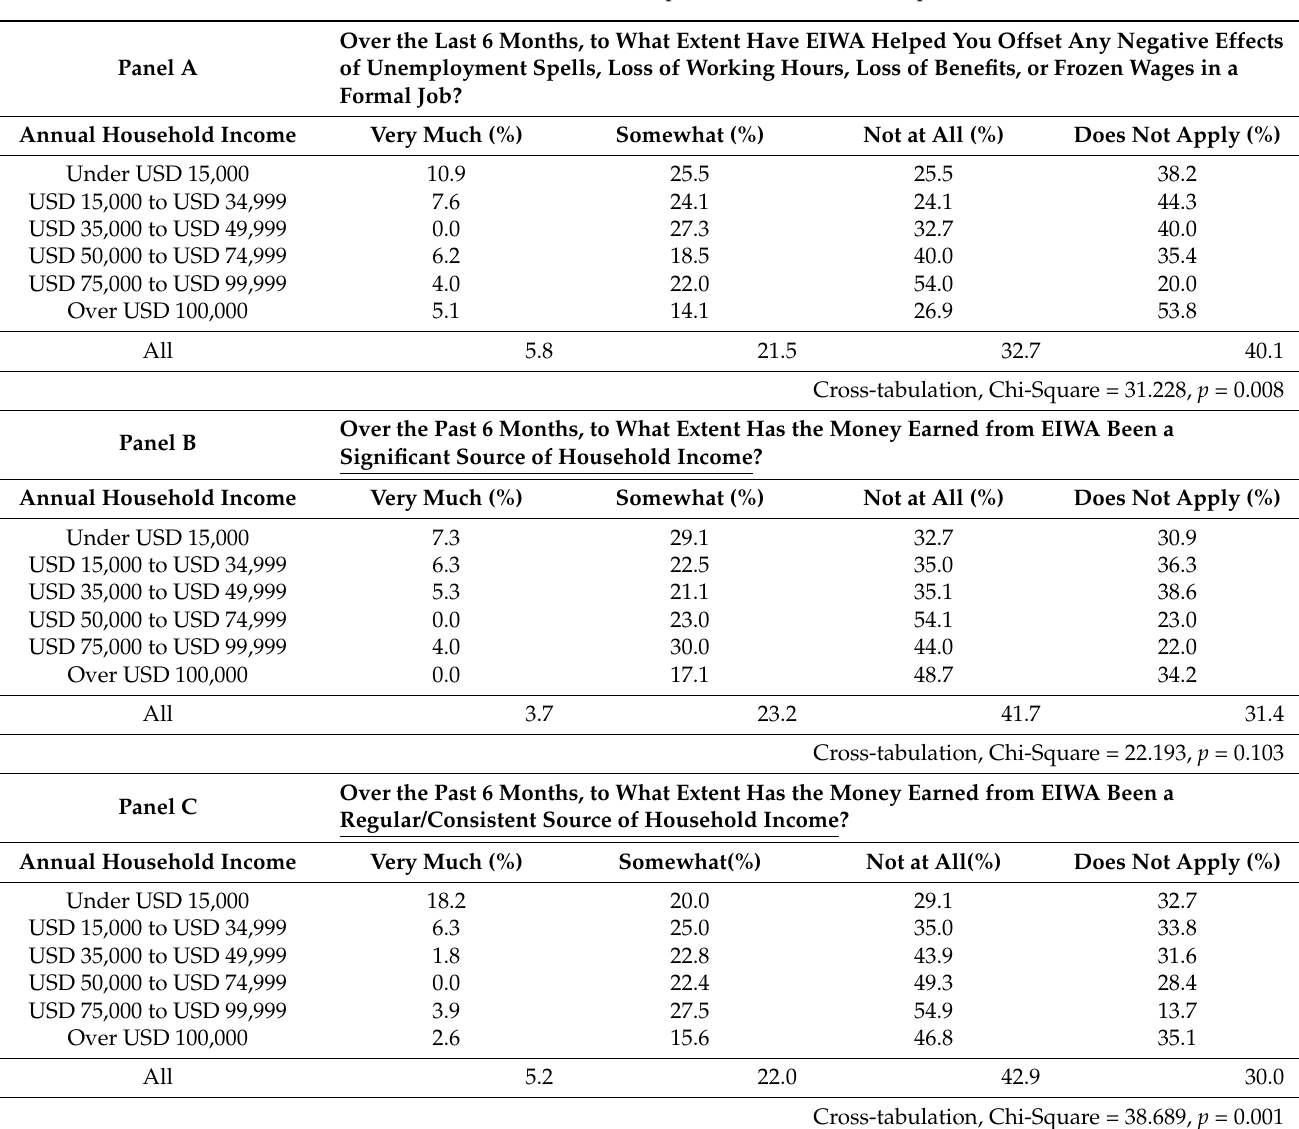
Table 10. Household Income and Importance of EIWA for Hispanics.